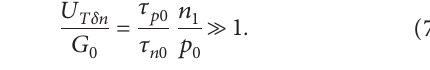
G (blue curve), U T T δ n / 0 (wine curve) for the system discussed in Figure pSRH